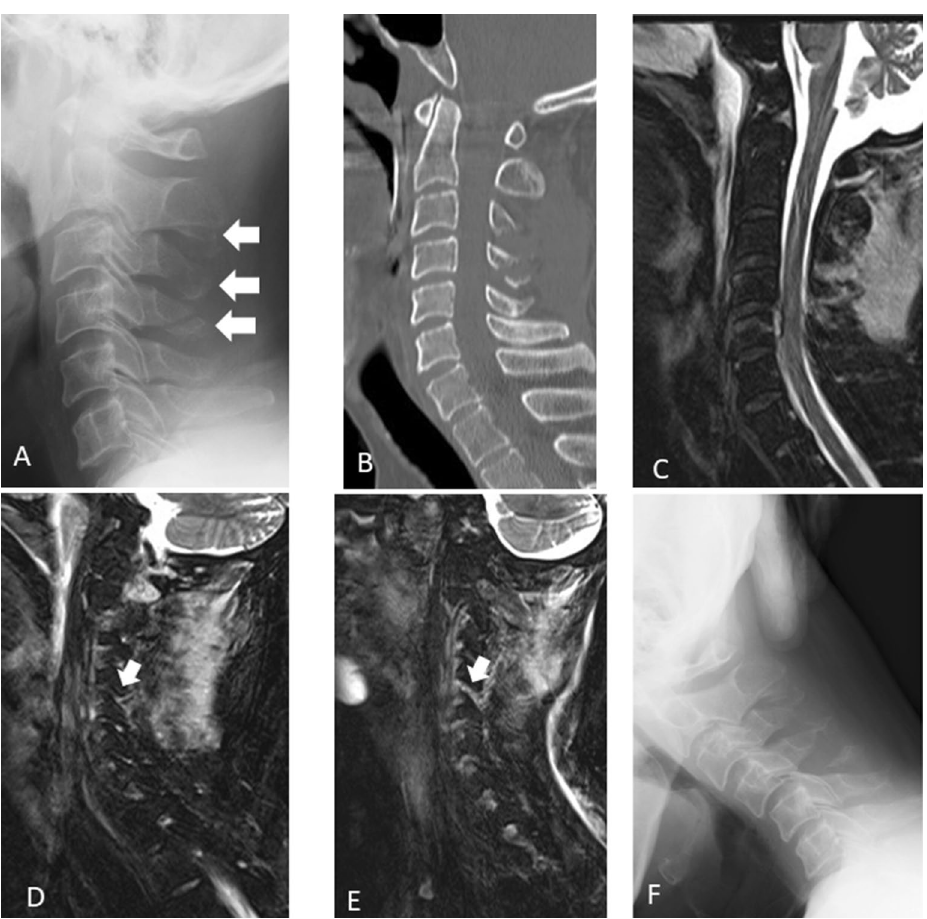
Figure 2. Assessment of cervical instability in a 56-year-old patient. ( A , B ) Lateral radiography image obtained at neutral position during the initial visit and mid-sagittal view of computed tomography scan. Radiography showed C2, 3, 4 spinous process fracture (white arrow). ( C ) Mid-sagittal view on magnetic resonance imaging and short tau inversion recovery image. ( D , E ) C4/5 facet effusion (white arrow). ( F ) Dynamic radiography showing segmental instability at